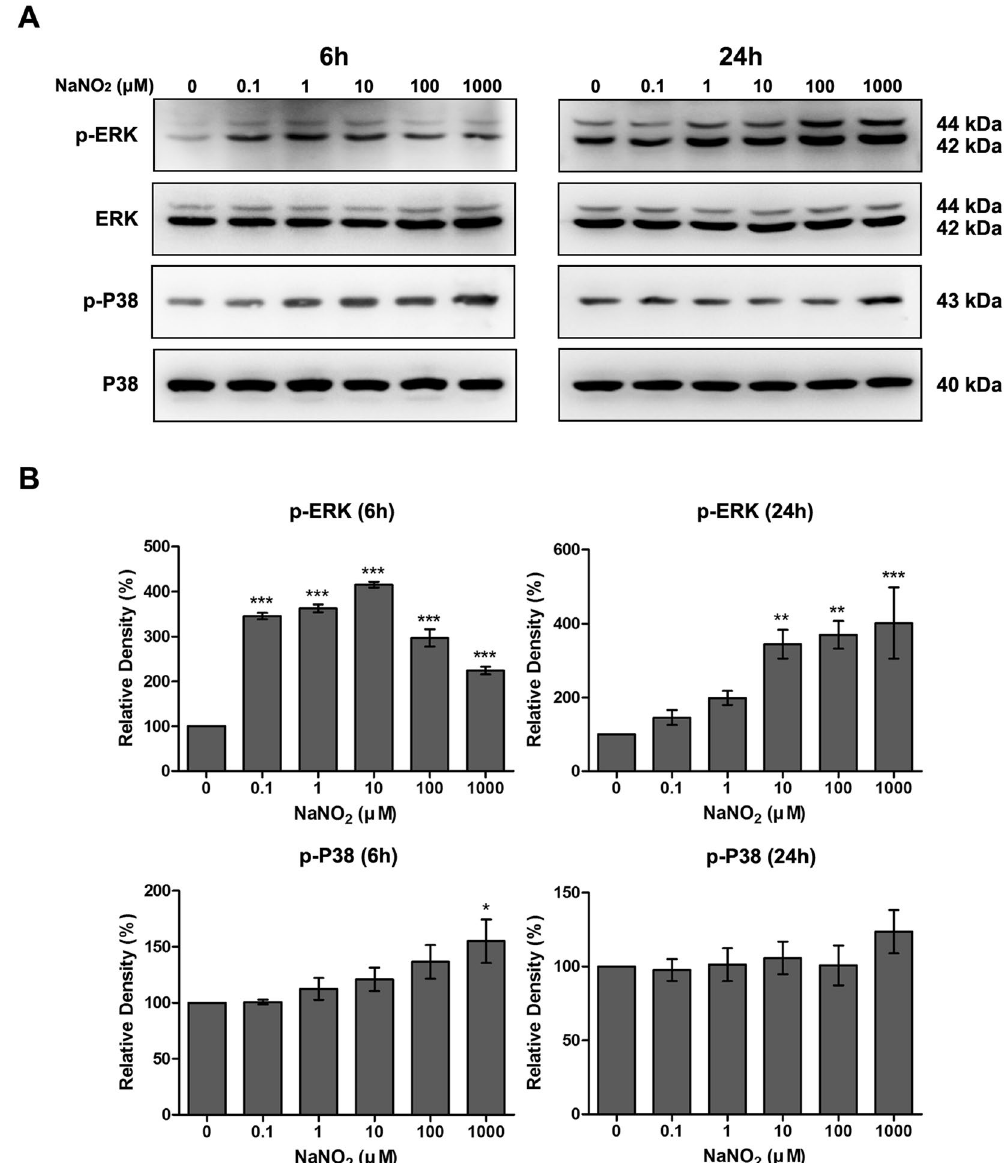
Figure 6. Effect of NO on MAPK activation of HCECs. The expression levels of phosphorylated ERK (p-ERK) and phosphorylated p38 MAPK (p-p38) were detected by western blot analysis after 6 and 24 h exposure to various concentrations of NaNO 2 ( A ). Relative densitometry ( B ) was calculated as a percentage of the control. It is clear that ERK phosphorylation increased at 6 and 24 hr. However, p38 MAPK phosphorylation increased only at 6 h, and with a high concentration (1000 μ M). Full size images of blots are available in the Supplementary information. Values are presented as mean ± SEM and were obtained from three independent experiments; each independent experiment was performed in triplicate. * p < 0.05, ** p < 0.01, *** p <